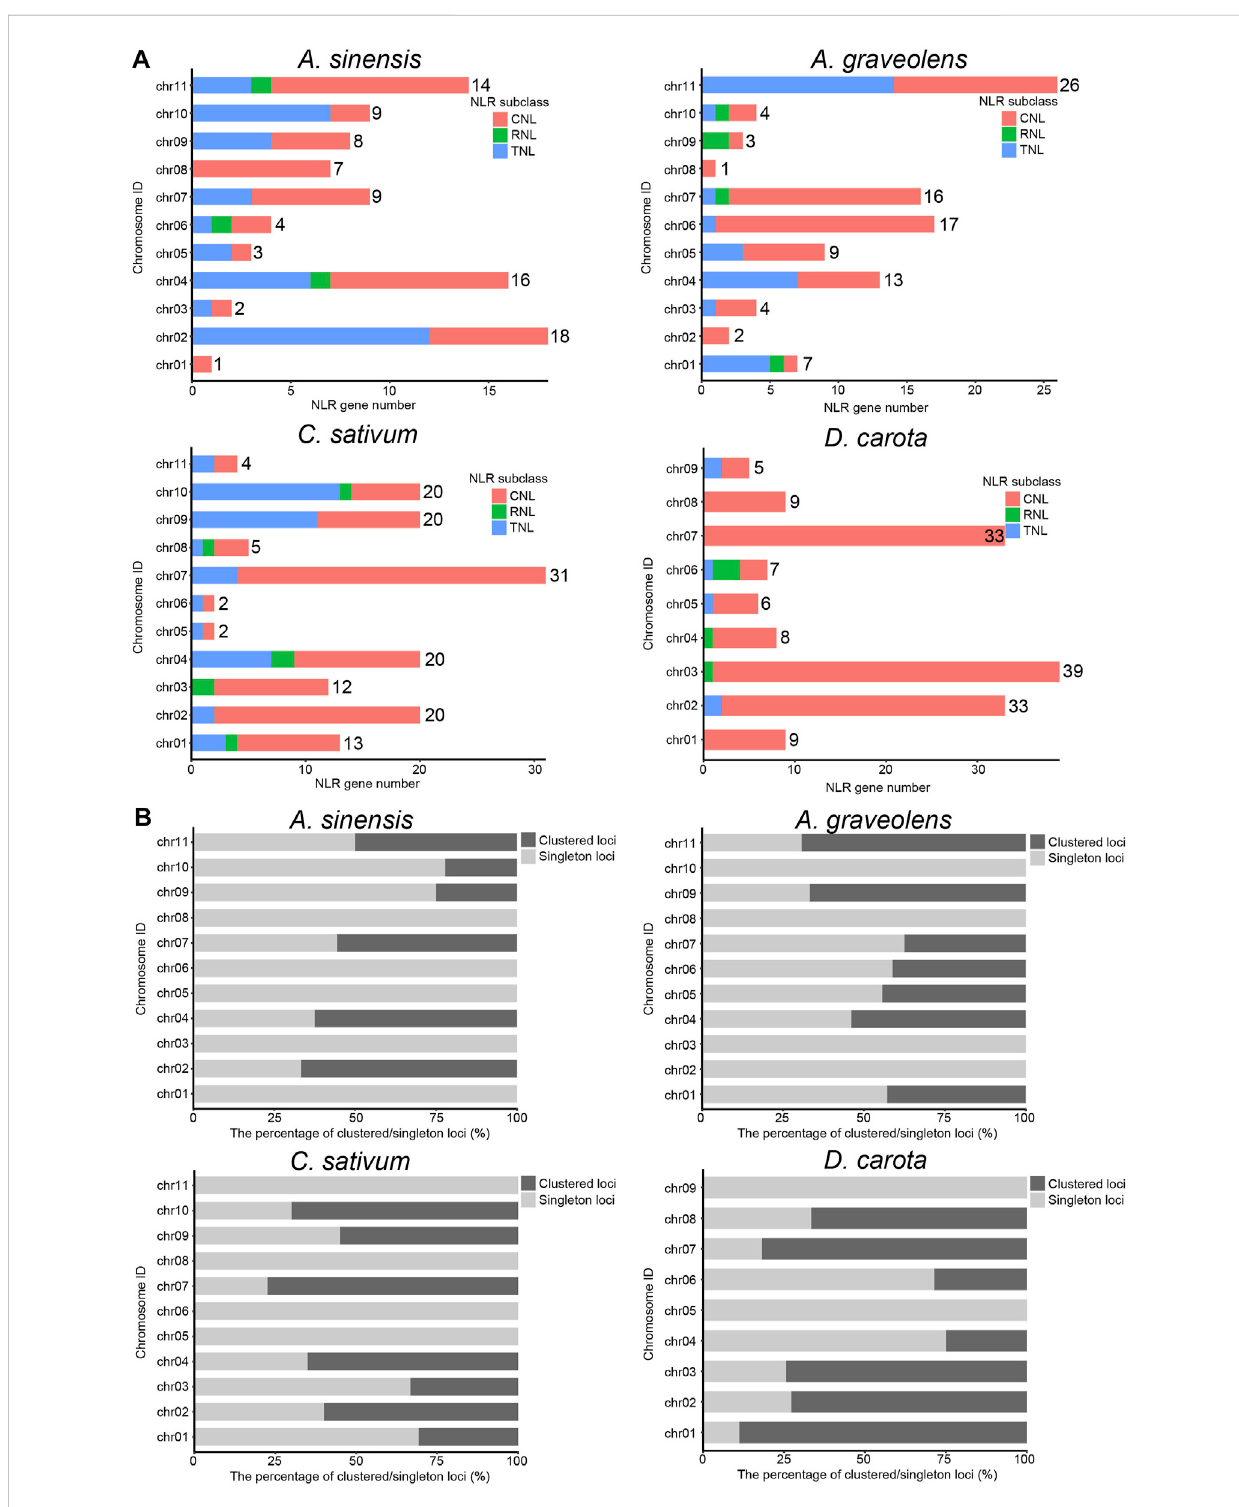
FIGURE 2 The composition and chromosomal distribution of NLR genes in four Apiaceae species. (A) The number variation of NLR genes among different genomes from four Apiaceae species. Three NLR subclasses are indicated with different colors, with red for CNL, green for RNL and blue for TNL. The number of NLR genes on each chromosome is shown. (B) The percentage of clustered/singleton loci among different genomes from four Apiaceae